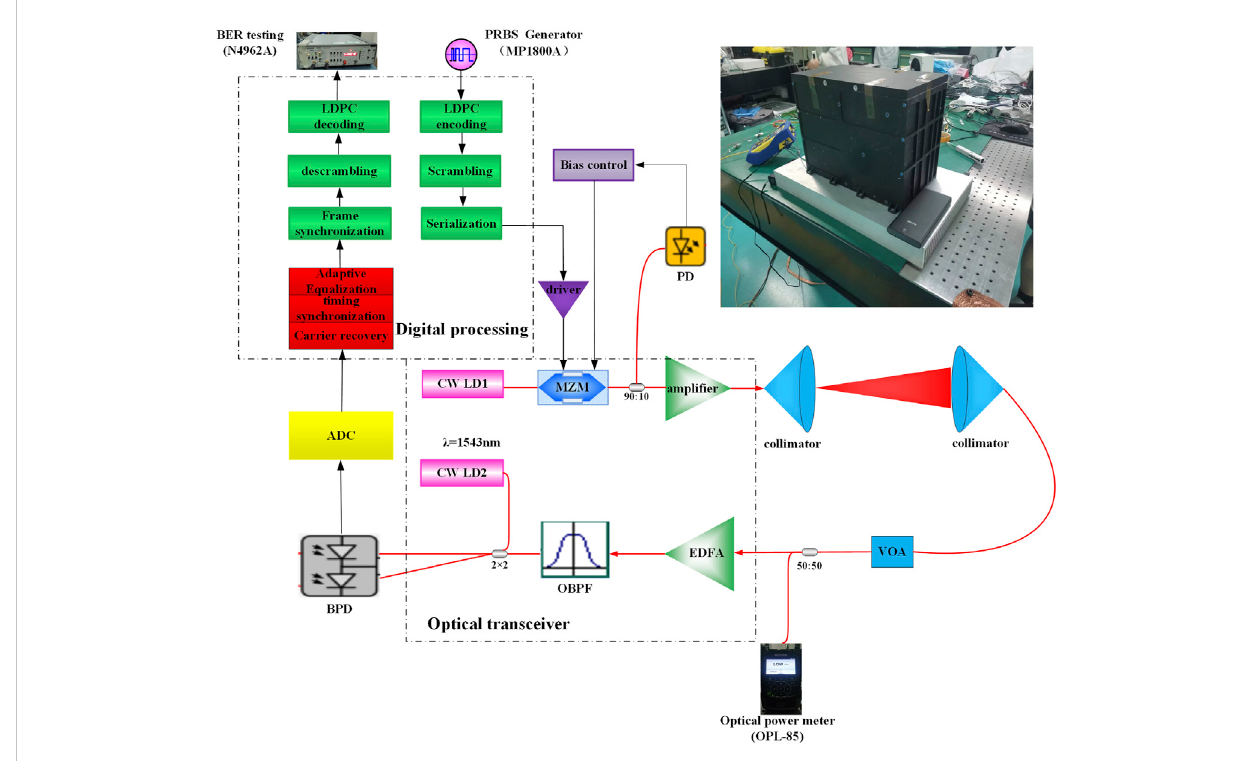
FIGURE 3 Schematics of BPSK transceiver integration.